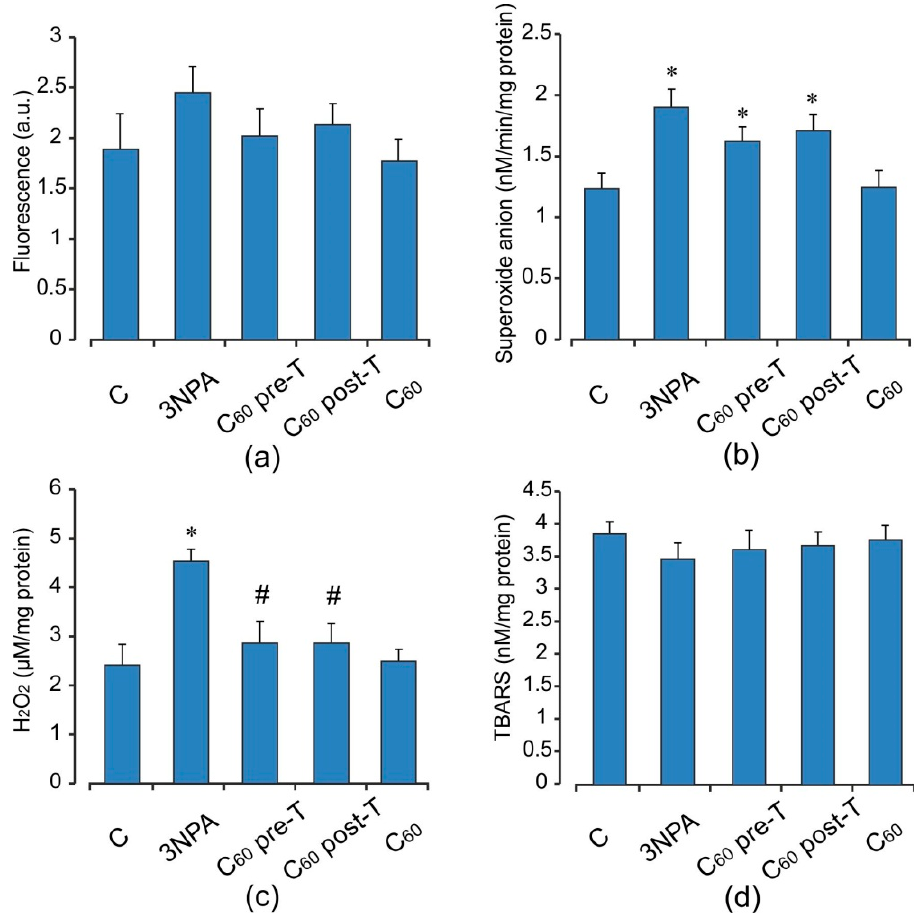
Figure 4. Effect of C 60 administration on oxidative stress markers: ROS formation ( a ), O 2 − ( b ), H 2 O 2 ( c ), and TBARS ( d ) production in skeletal muscle mitochondria of 3-NPA-treated rats. Values are means ± SD (replicates=8). The data were analyzed for statistical significance using ANOVA followed by the Bonferroni post hoc test. (C)—control; (3NPA)—3-nitropropionic acid treated rats; (C 60 pre-T)—C 60 administration in pre-treatment regimen; (C 60 post-T)—C 60 administration in post-treatment regimen; (C 60 )—C 60 administration alone. * p < 0.05 vs. control group; # p < 0.05 vs. 3-NPA treated rats.